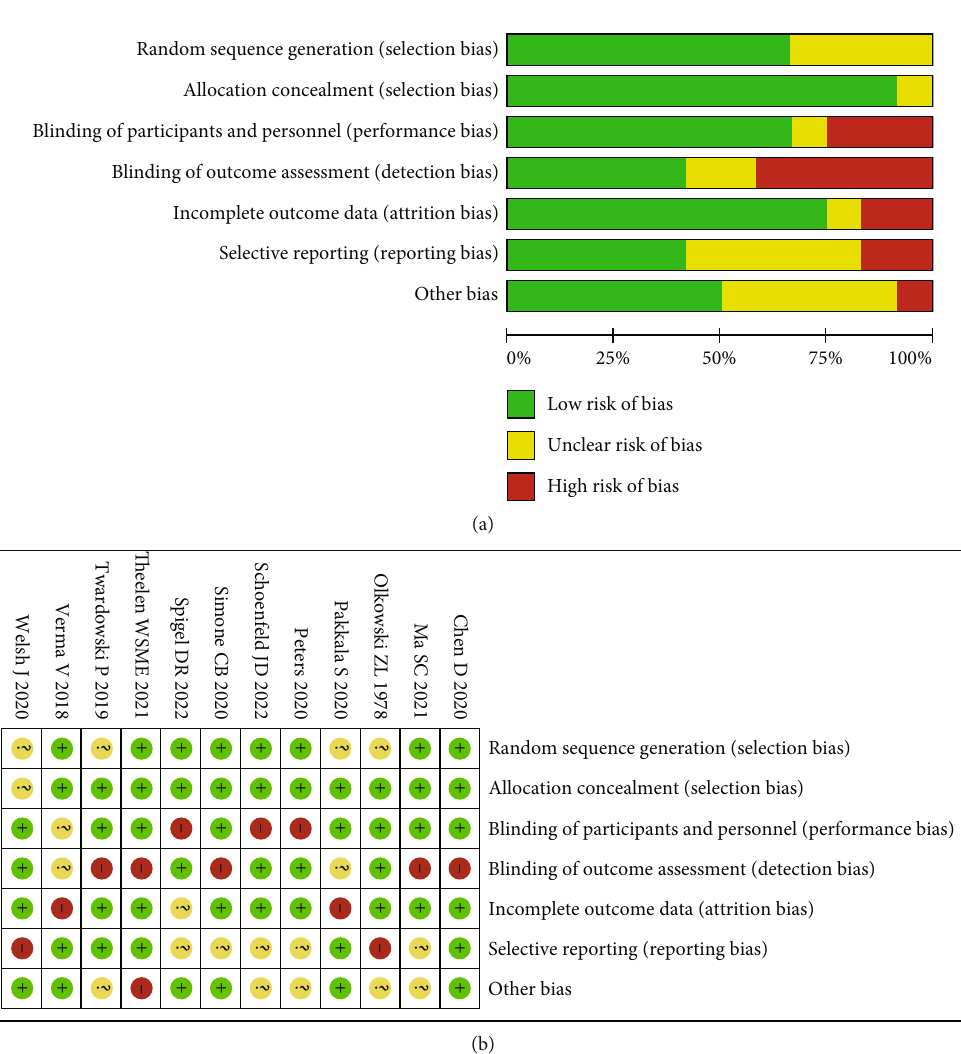
speci fi c tumor antigen, and tumor cells are speci fi cally iden- ti fi ed and killed back in vitro [27 – 30]. T cells are a T cell that is not MHC limiting and is a class of immune cells recently